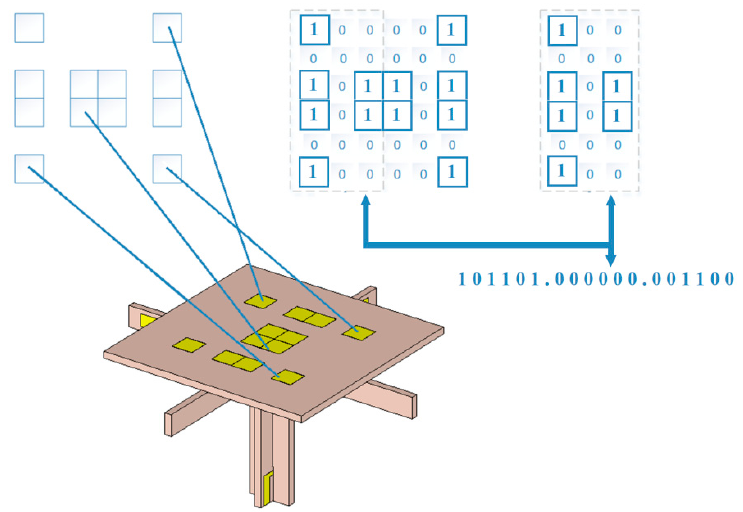
Figure 3. Cross-dipole antenna and resonator plane in a binary system.